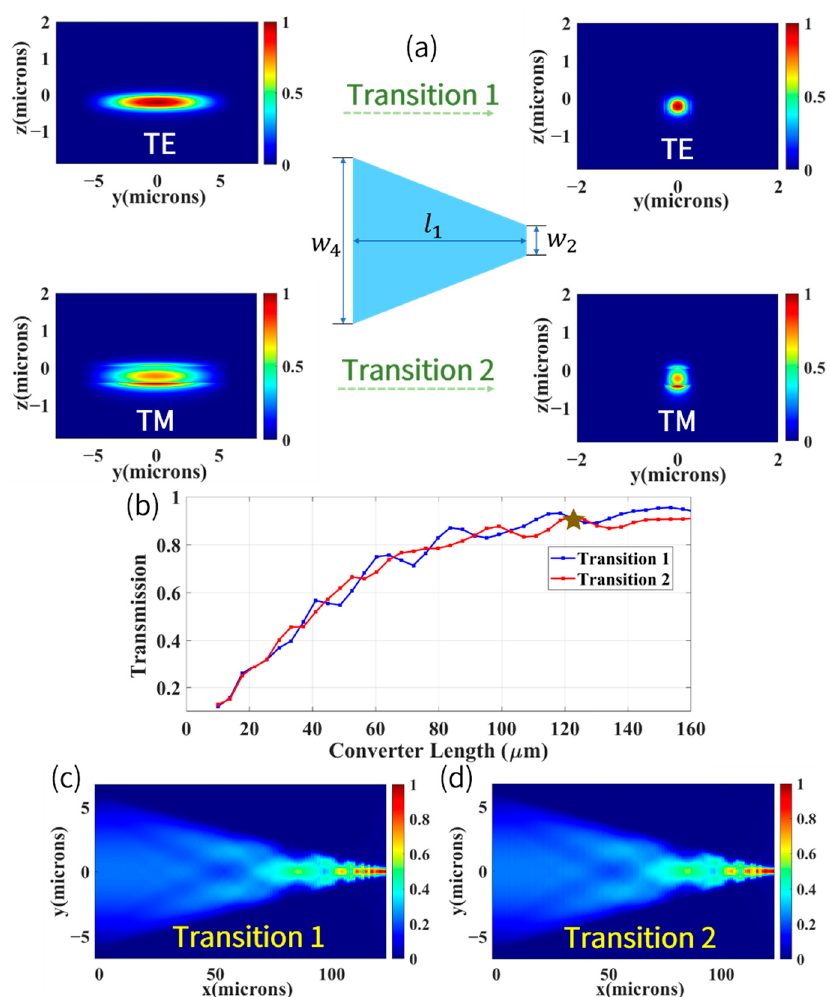
Figure 6. ( a ) Top view of the mode converter and its functionality. ( b ) Transmission of the Transition 1 and Transition 2 as a function of length of the mode converter. ( c ) Simulated electric field profile for Transition 1 at a wavelength of 795 nm. ( d ) For Transition 2.